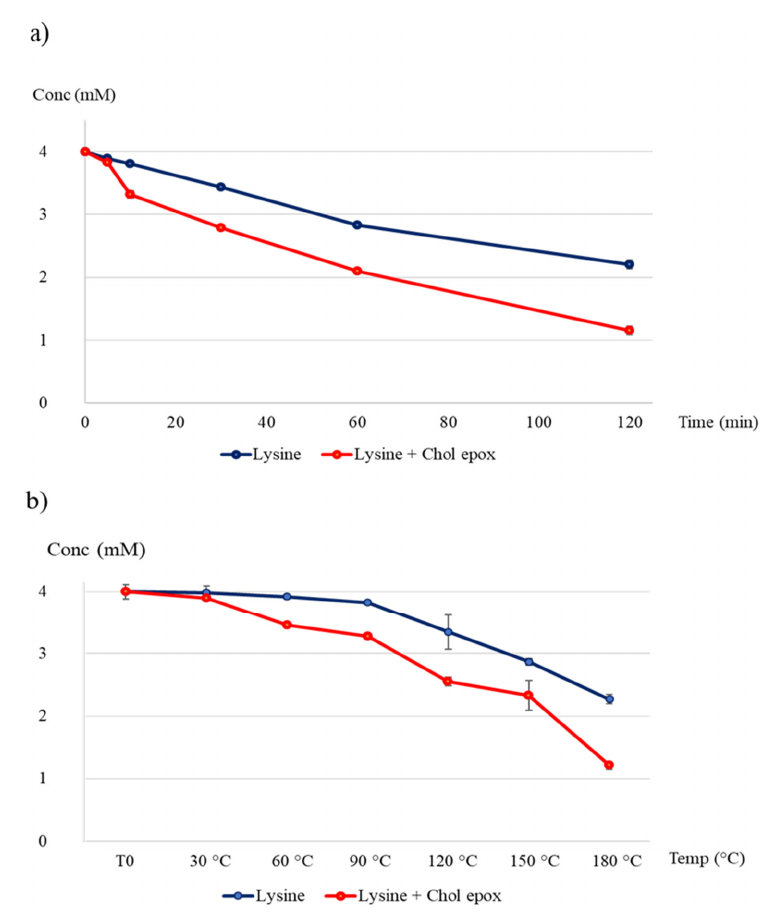
Figure 7. Overlaid chromatograms of N α -benzoylglycyl- l -lysine and derivatives in mixture reaction samples after different times of incubation at 180 °C (T1: 5 min, T2: 10 min, T3: 30 min, and T4: 60 min).